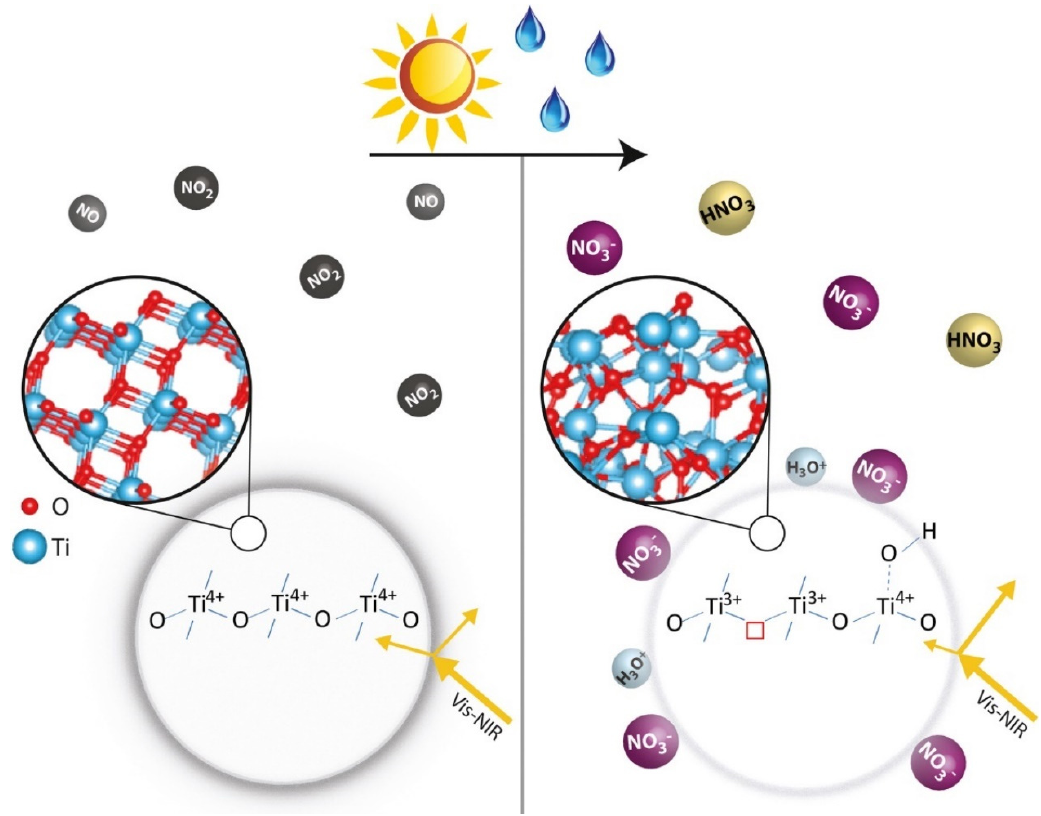
Figure 6. Scheme showing the reactions occurring at the surface of TiO 2 (anatase phase) [126] .